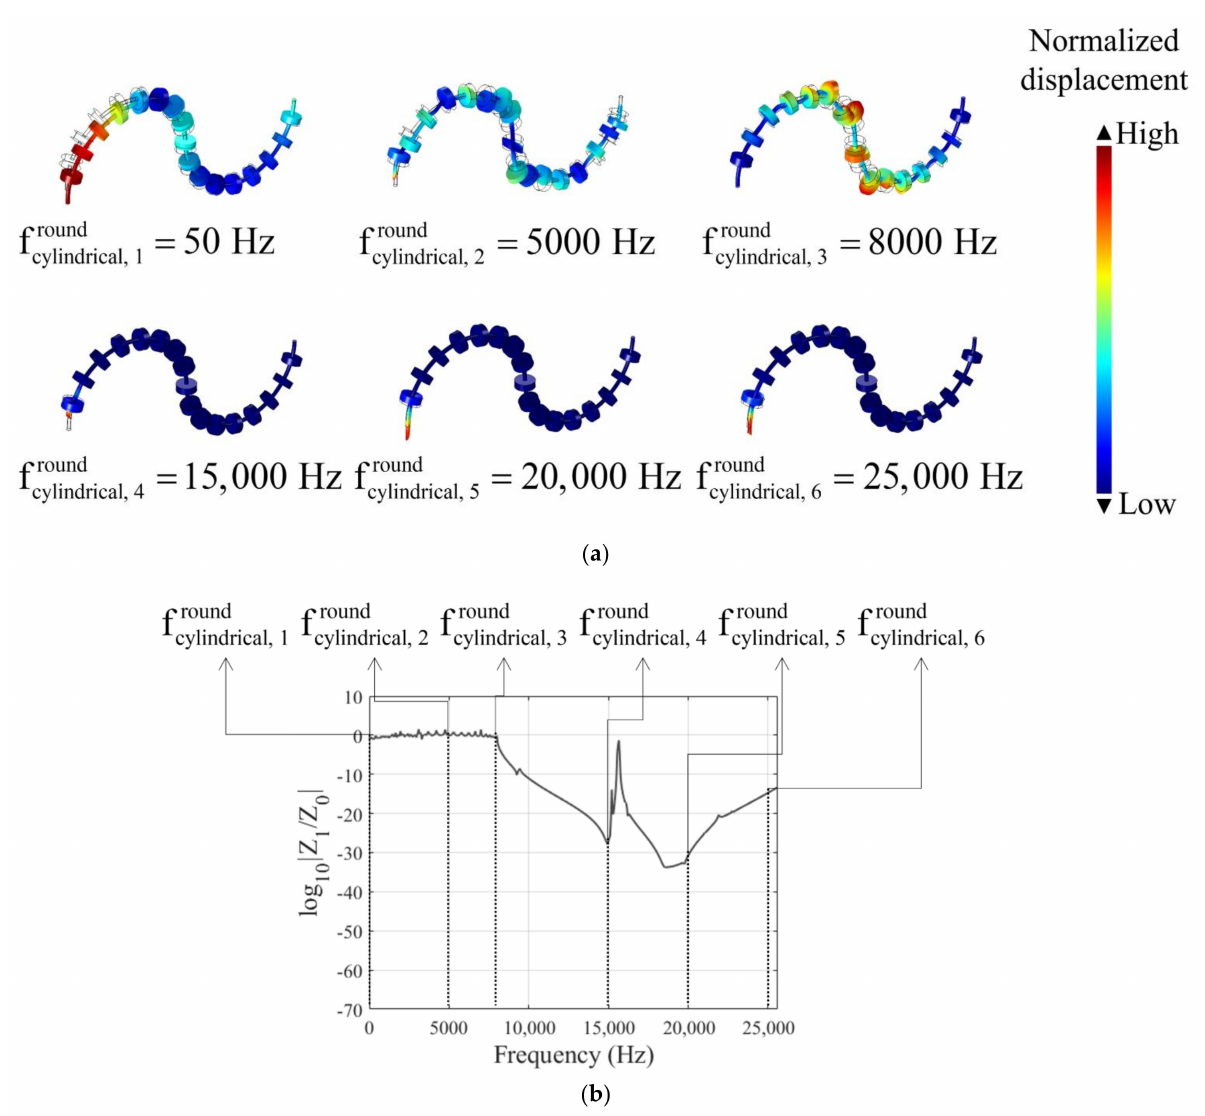
Figure 19. ( a ) Displacement at a specific frequency of the round cylindrical metamaterials and ( b ) the frequency responses ( r p = 0.03 m, h p = 0.02